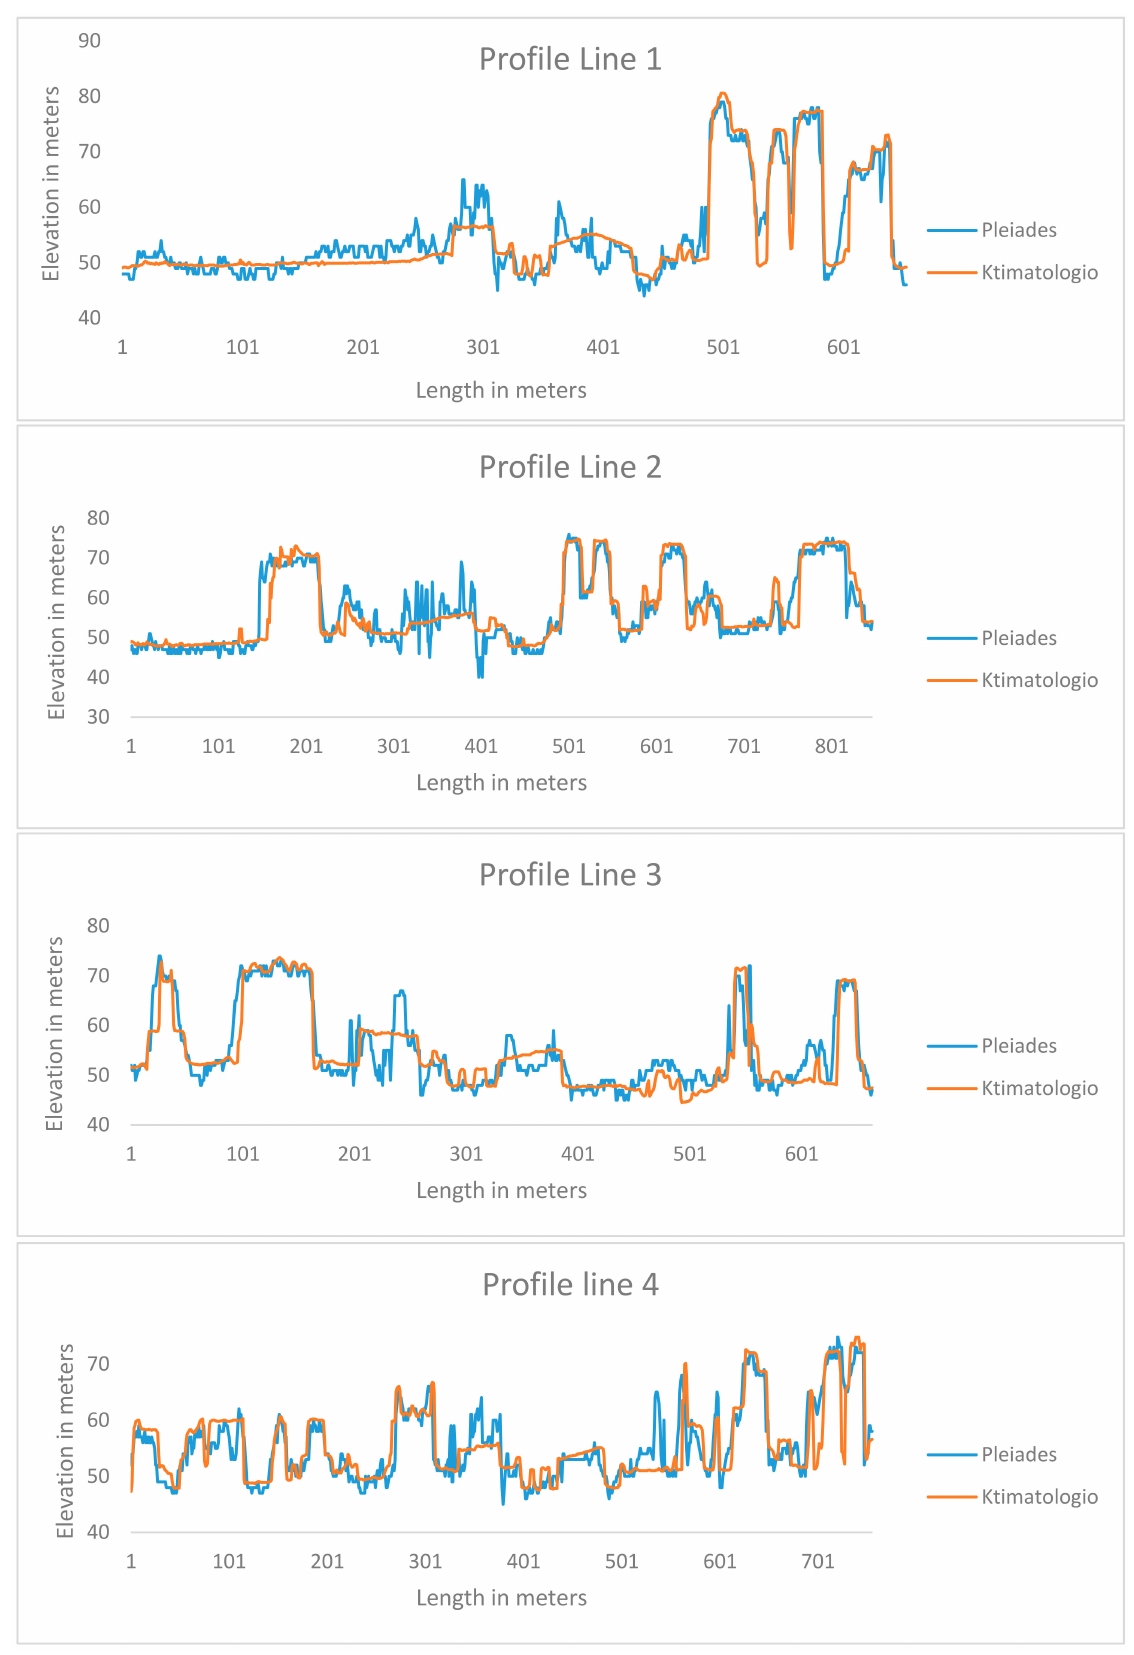
Figure 9. Line profiles with elevation data from Pleiades and